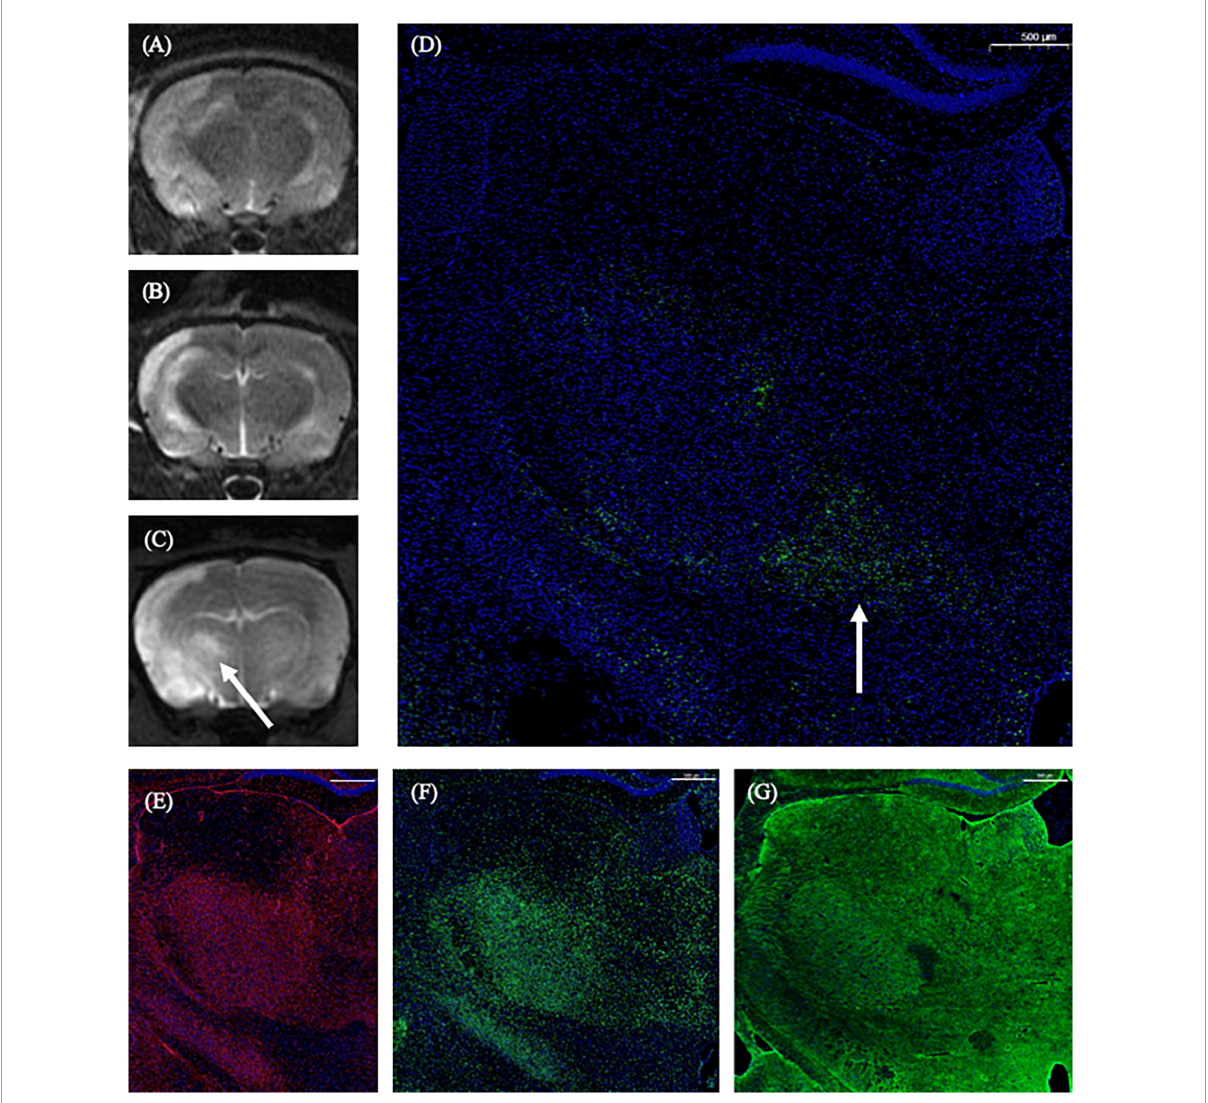
FIGURE8 The correspondence between DCE-MRI and immunofluorescence staining results in the thalamus VPN. On the 1st day and the 2nd week after MCAO, the ipsilateral thalamus VPN was almost normal at T2-weighted MRI (A,B) . At the 2nd week after MCAO, the abnormal aggregation area of contrast medium at 3D T1-weighted MRI (C) included almost all the ipsilateral thalamus VPN, which was roughly consistent with the astrocytes and microglia activation (E,F) , and the AQP4 depolarization (G) . The tendency of the APP deposition (D, arrow) was consistent with the one of the contrast medium retention in DCE-MRI (C, arrow) in the ipsilateral thalamus VPN. Bar = 500 µ m. DCE-MRI, dynamic contrast-enhanced MRI; MCAO, middle cerebral artery occlusion; VPN, ventroposterior nucleus; AQP4, aquaporin 4; APP, Beta-amyloid precursor